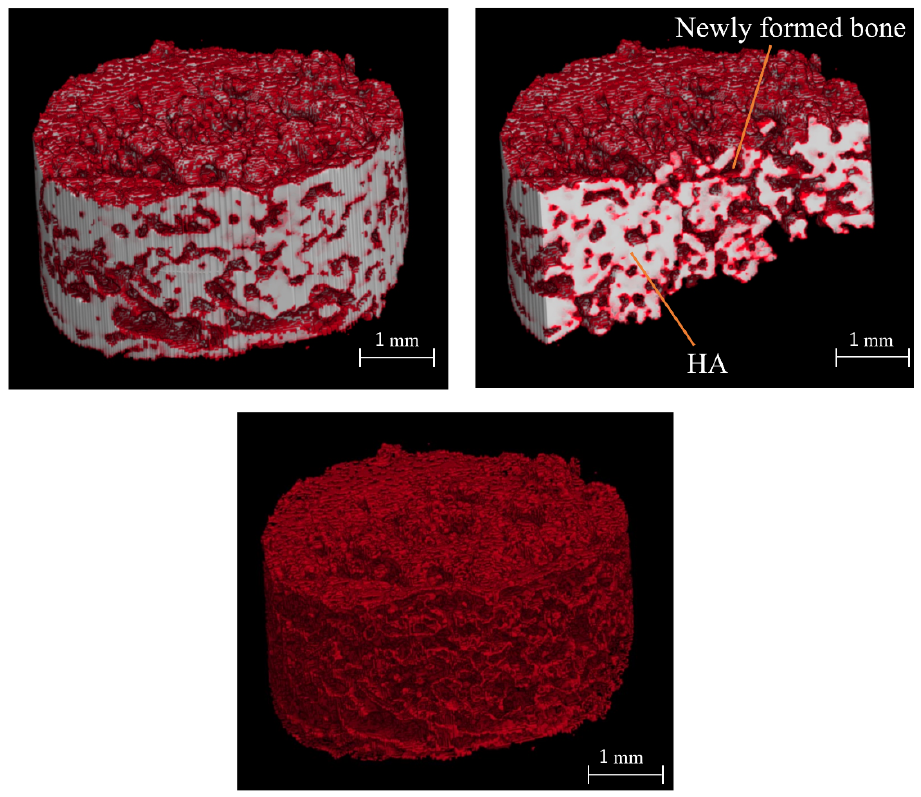
Figure 14. ROI extraction 3DCT images of bone defects filled with biphasic HA granules. (White: HA granules, Red: Newly formed bone).